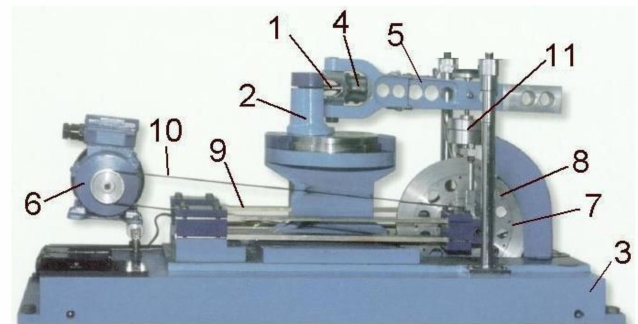
Figure 2. MZGS-100 machine, where: 1—specimen, 2—rotational head with a holder, 3—bed, 4—holder, 5—lever, 6—motor, 7—rotating disk, 8—unbalanced mass, 9—flat springs, 10—driving belt, 11—hydraulic connector.